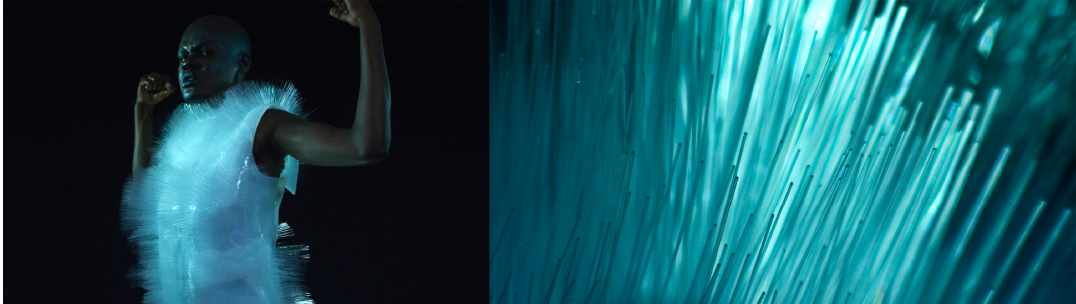
Fig ure 2. Opale , emphatic dress by B. Farahi. Courtesy B. Farahi Figure 2. Opale , emphatic dress by B. Farahi. Courtesy B.